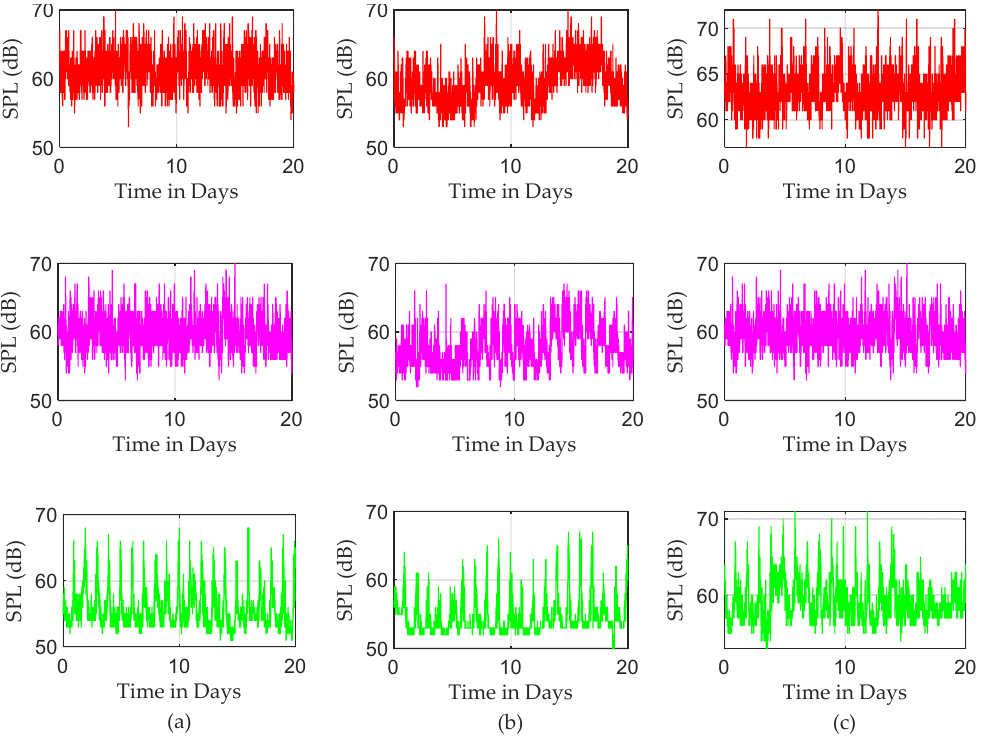
Figure 6. Decomposition the time series of the recorded SPLs; red, pink, and green column plots are SPL time series for daytime, evening, and night (each 8 h a day over 20 days): ( a ) ICU1, ( b ) ICU2, and ( c ) ICU3.